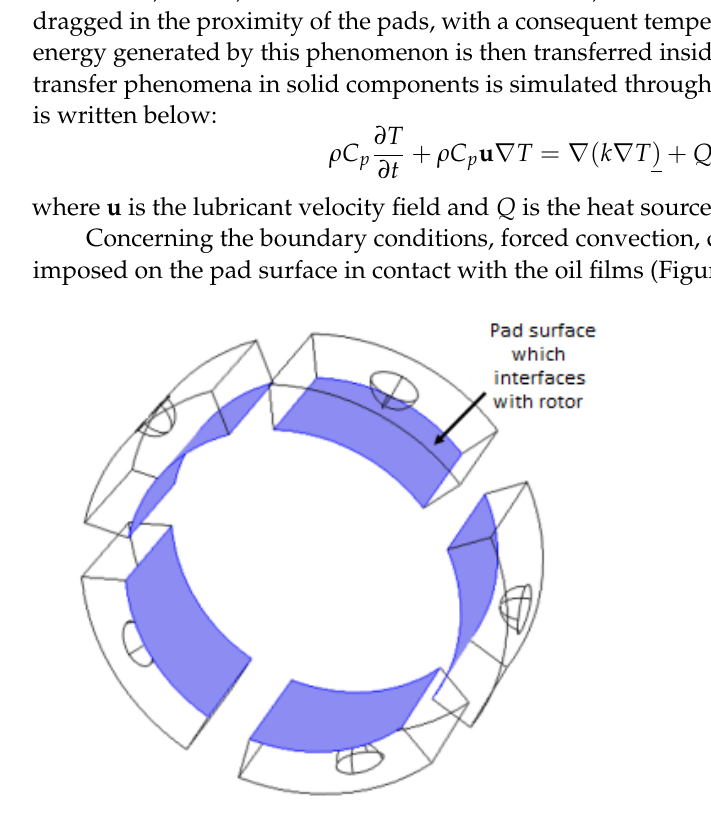
Figure 7. Pads surfaces concerned by the convective heat transfer with the